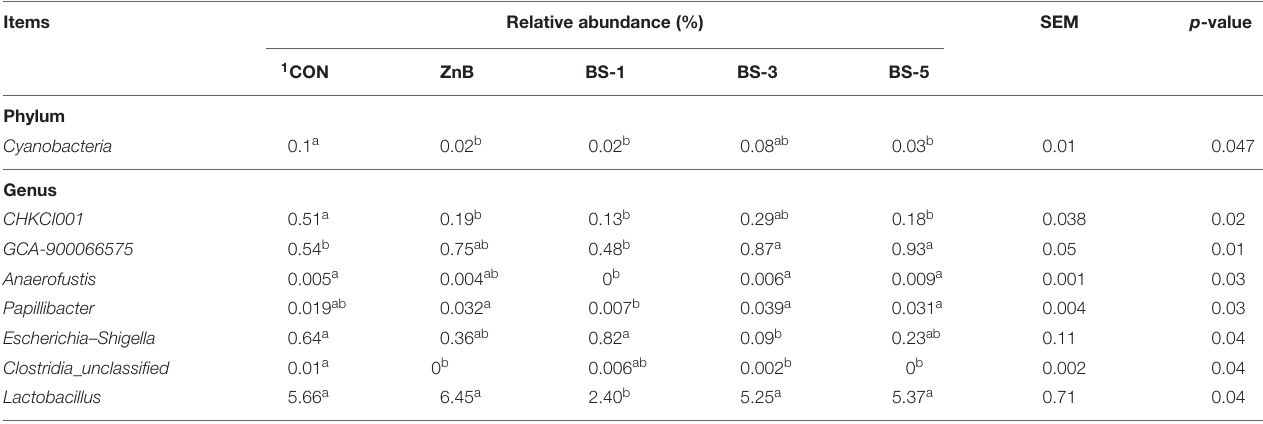
TABLE 7 | Effect of dietary supplementation of Bacillus subtilis ATCC19659 on bacterial taxonomy within the cecal contents of broilers. Items Relative abundance (%) SEM p -value 1 CON ZnB BS-1 BS-3